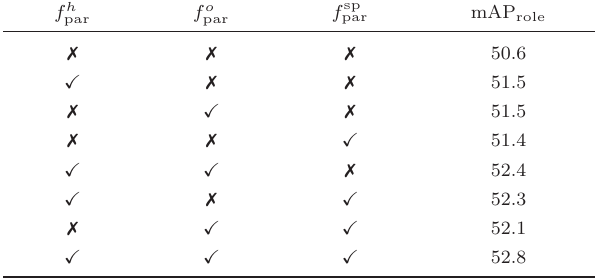
Table 5 Effect of each component of the part-level pairwise feature, for the V-COCO test set f h f o f sp par mAP role par par